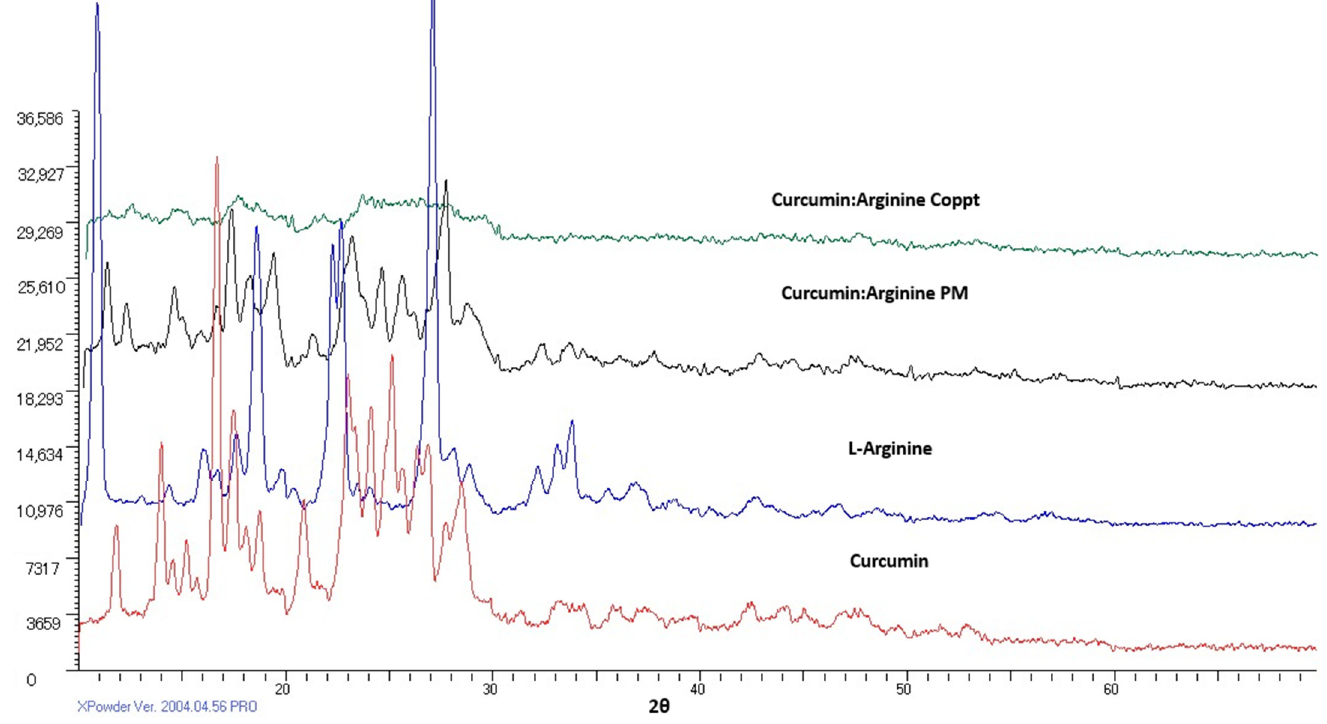
Figure 5. XRD spectra of curcumin, curcumin–L-arginine physical mixture, and coprecipitated dispersion.